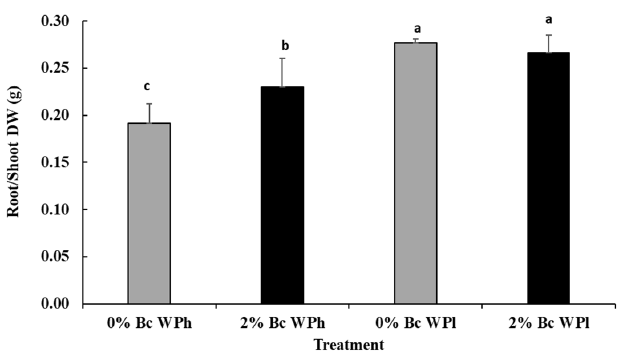
Figure 2. Root–shoot ratio in Medicago ciliaris after 3 weeks of drought treatment. Values represent mean ± SE ( n = 5) and the different letters a to c indicate significant differences between the treatments. Low soil water potential (WPl), high soil water potential (WPh), Biochar (Bc).